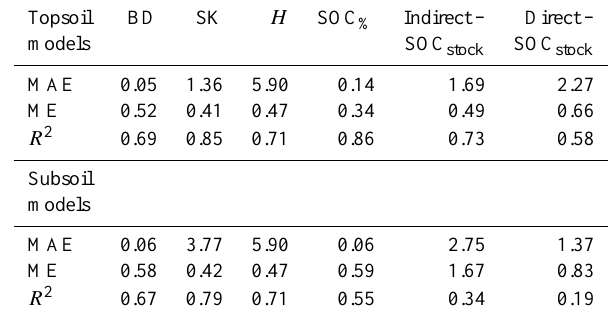
Table 4. Fitting performance for the respective models. The model’s efficiency (ME) is the ratio between the model’s mean ab- solute error (MAE) and the MAE that would result from only using the mean value as the model. Cubist reports the ME as relative er- ror, but it is renamed here to avoid confusion with the more common definition of relative error. An ME of greater than 1 indicates that the model is not performing well.